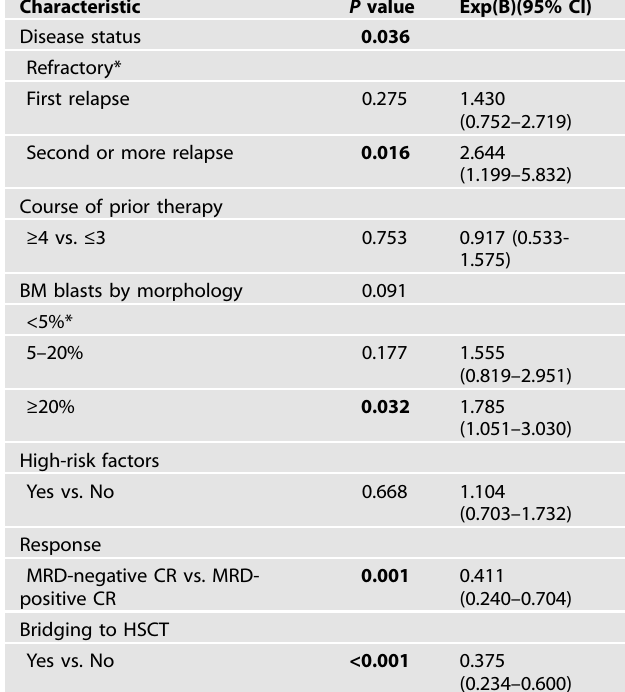
Table 4. Multivariate analysis for